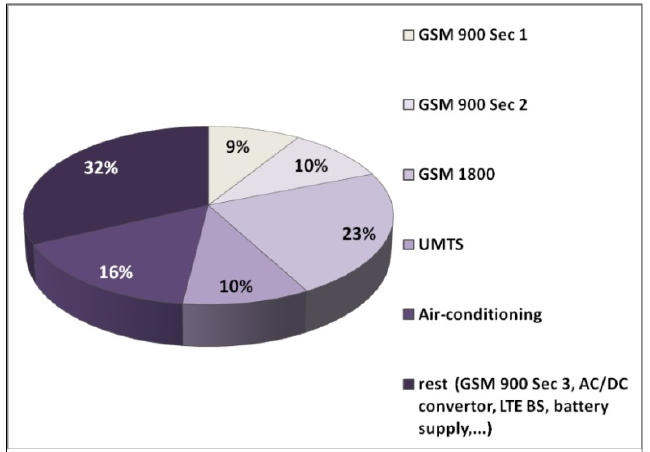
Figure 17. Distribution of the total active power consumption of the analyzed BS site.